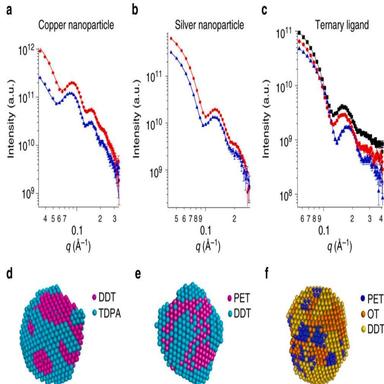
SANS data and models for various nanoparticles. (a) SANS data and fits for TDPA and dDDT-coated copper nanoparticles in deuterated toluene (red) and deuterated/hydrogenated toluene mixture (blue). Corresponding 3D model in (d) with blue beads (TDPA) and red beads (dDDT) ligands. (b) SANS data and fits for dPET and DDT-coated silver nanoparticles in the same solvent conditions as copper nanoparticles. Corresponding 3D model in (e) with blue beads (DDT) and red beads (dPET) ligands. (c) SANS data and fits fo